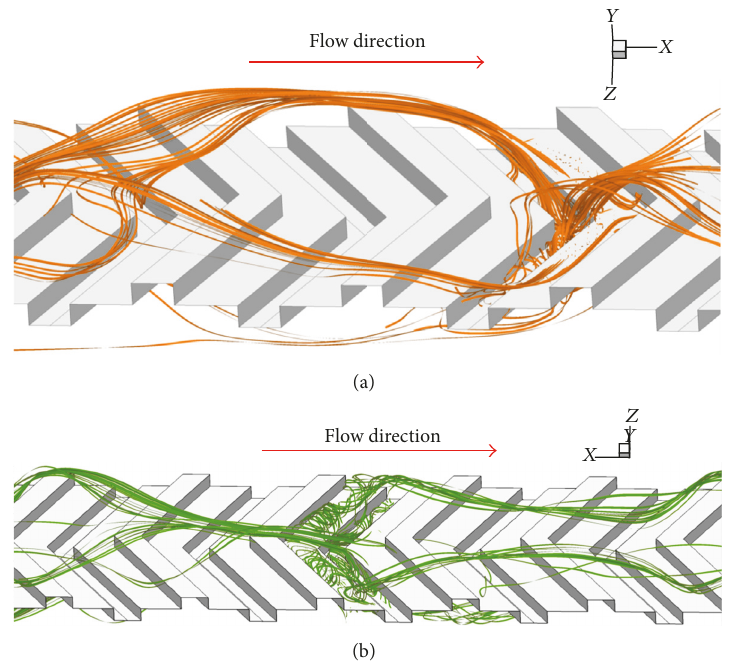
Figure 6: Longitudinal vortex flow of the square channel heat exchanger inserted with 45 ∘ V-wavy plate at Re = 3000 for (a) V-Downstream and (b) V-Upstream.